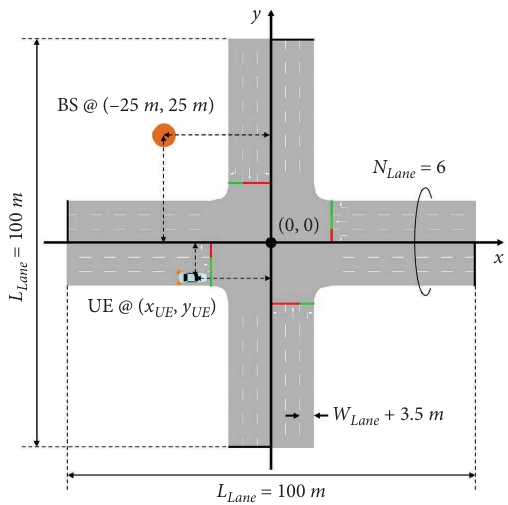
Figure 4: Urban intersection simulation environment with road parameters.